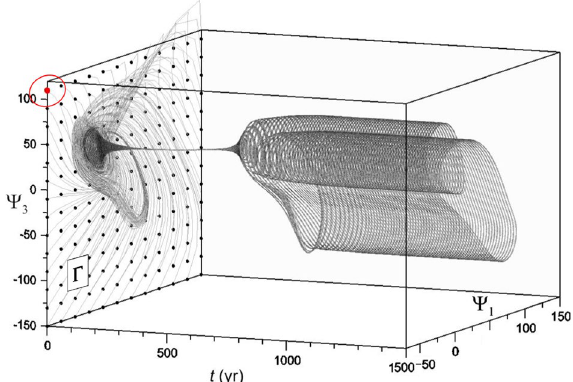
Figure 4. ES subject to the same forcing used in the single forward time integrations of Fig. 3a, b. The filled red circle in the oval indicates the initial state used to initialize the four simulations of Figs. 2 and 3. After an initial transient, it is visually obvious that the ES converges to a stable cylinder-shaped PBA, obtained by the translation in time of an autonomous limit cycle.